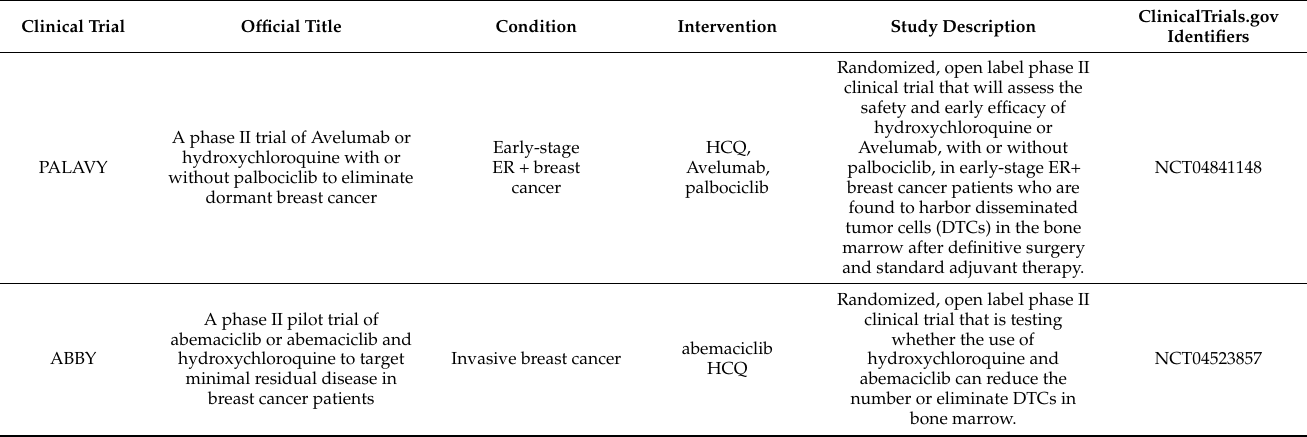
Table 2. Clinical trials in breast cancer patients with CDK4/6 and autophagy inhibitors. Information obtained from ClinicalTrials.gov in December 2021.